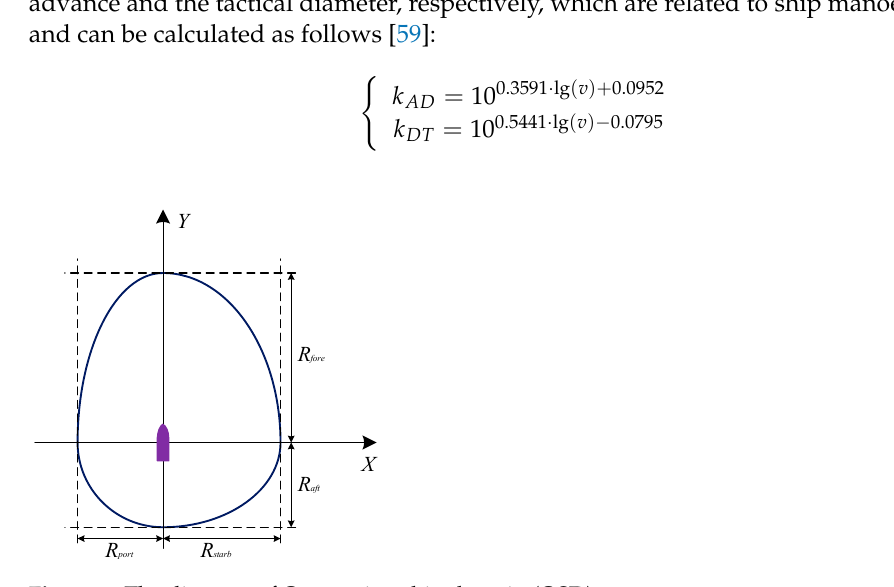
Figure 5. The diagram of Quaternion ship domain (QSD).